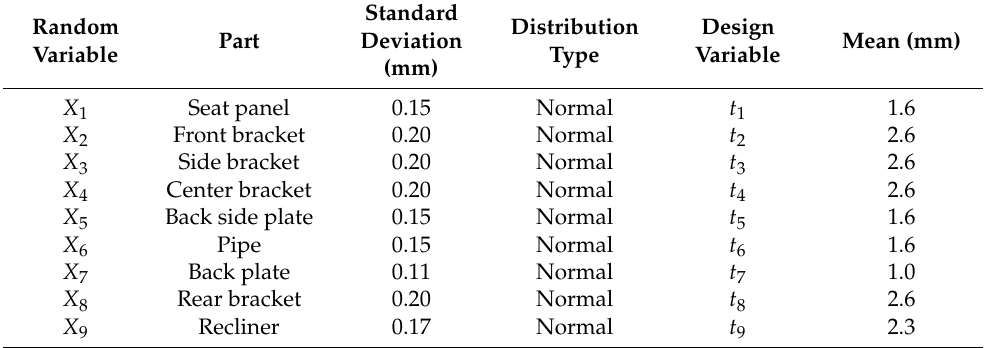
Table 3. Definition of random